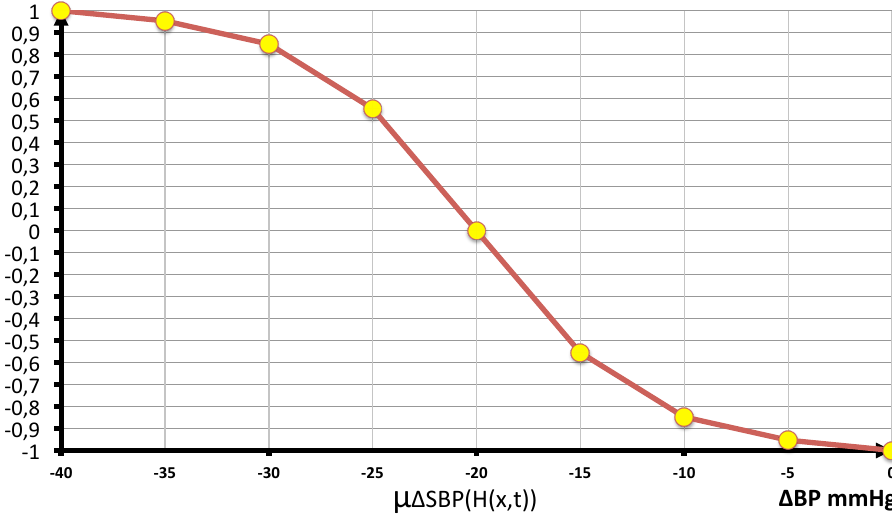
Figure 24. Fuzzy characteristic function µ ∆ SBP ( H ( x , t ) for 15